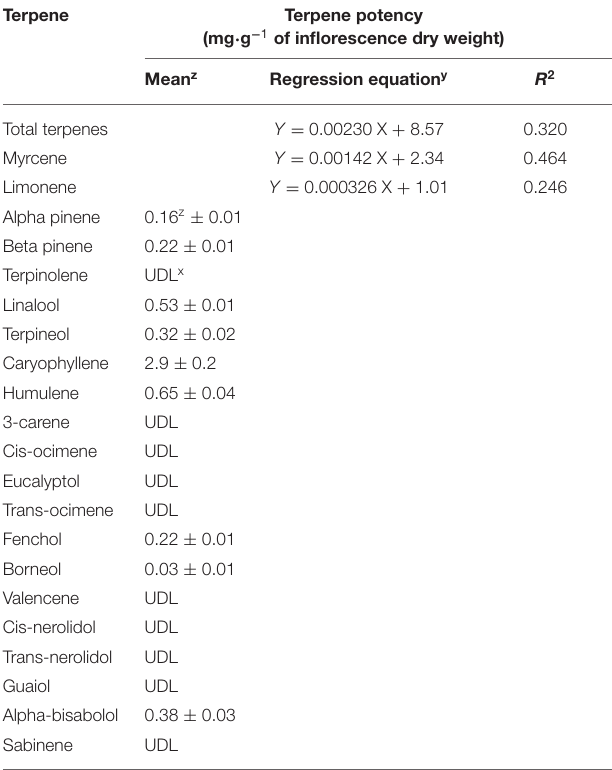
TABLE 2 | The relationships between average photosynthetic photon flux density (APPFD) applied during the flowering stage (81 days) and terpene potency in apical inflorescences of myrcene, limonene and total terpenes, and the mean potency for terpenes with no APPFD treatment effects, of Cannabis sativa